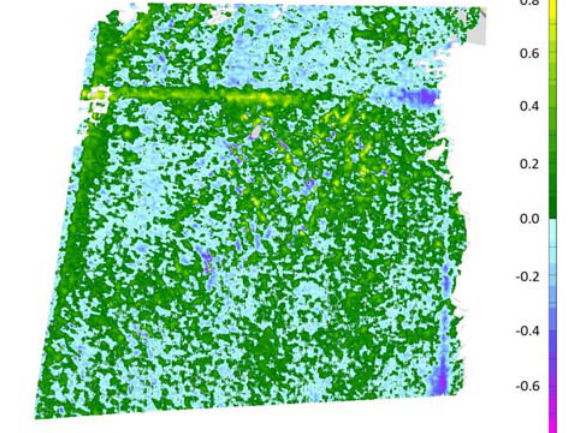
Figure 10 – Error map: DM, Template 25, Area02 with threshold for matching acceptance